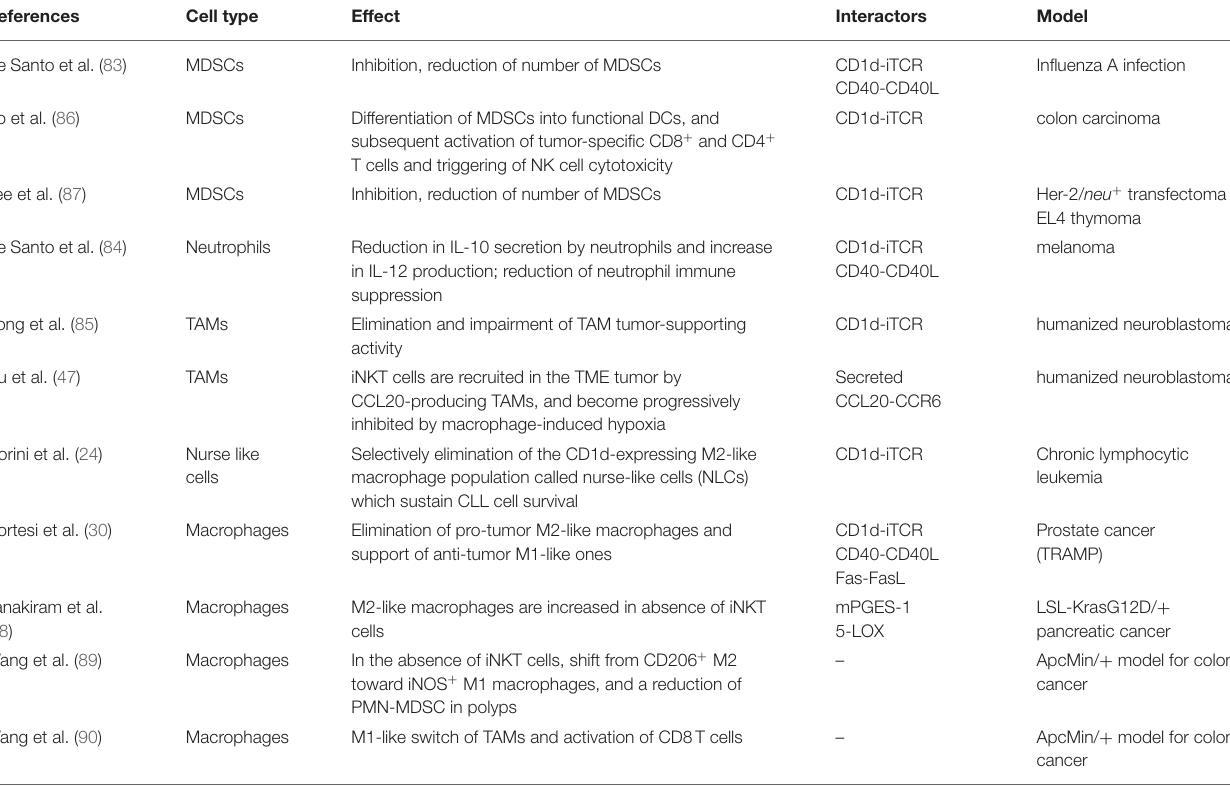
TABLE 1 | iNKT cell interactions in the tumor